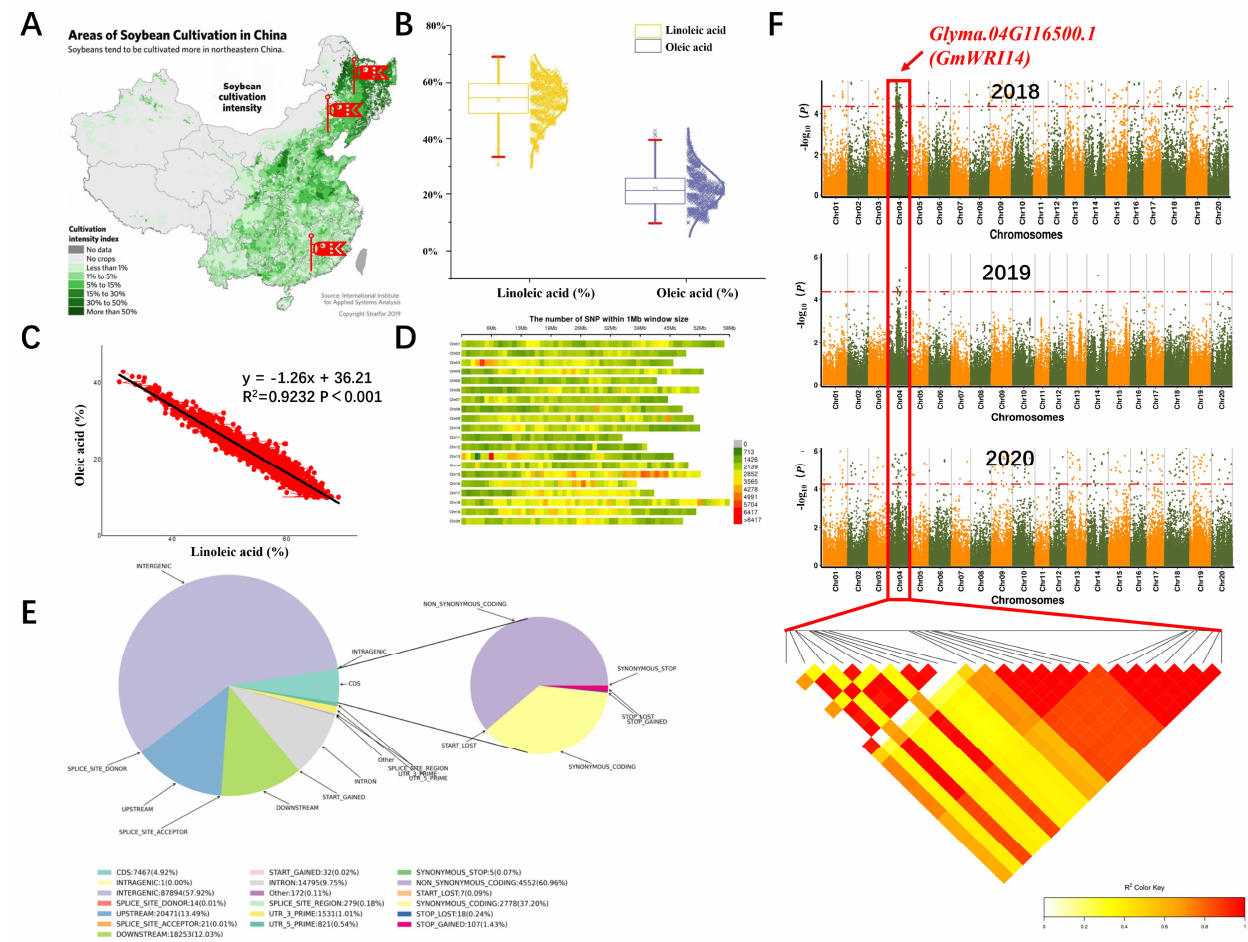
Figure 1. Phenotyping and genotyping of 510 soybean germplasms. ( A ) A total of 510 soybean germplasms from China (Heilongjiang province, Shandong province, and Guangdong province) were collected as the natural population. ( B ) The distribution of the LA content of different soybean lines resembled the bell-shaped curve of a normal distribution. ( C ) The association between the percentages of oleic acid and LA, y = − 1.26x + 36.21, is a linear equation, where x represents the LA content and y represents the oleic acid content. ( D ) Distribution map of SNPs on different chromosomes. The abscissa is the length of the chromosomes. Each band represents one chromosome. ( E ) Pie chart of SNP annotations. Left panel: SNP percentages generally associated with genes. ( F ) Genome-wide Manhattan plots of associations for LA content for a 2018–2020 analysis. In the left panel, the x -axis indicates the SNPs along each chromosome; the Y -axis indicates the − log 10 ( p -value) for the